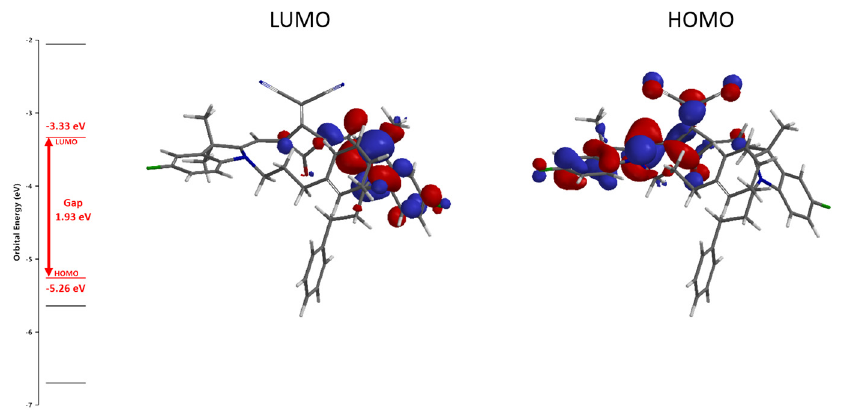
Figure 6. Theoretical calculations of HOMO/LUMO energy levels of compound 5 were obtained from Spartan 18 V1.4.5 software (Wavefunction, Inc., Irvine, CA, USA). DFT calculation was achieved at the B3LYP/6-311G level.